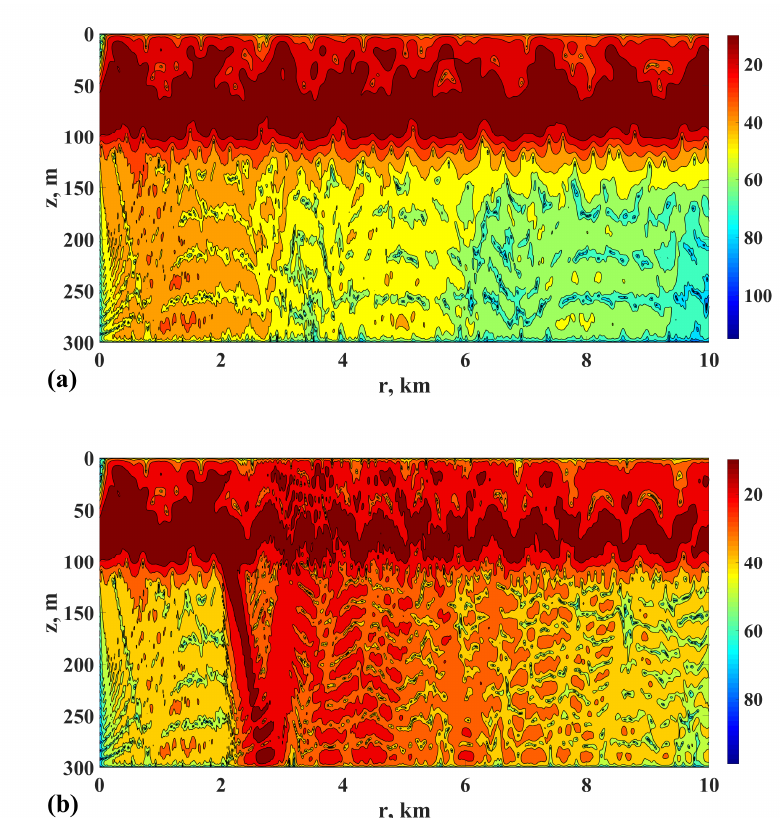
Figure 4. Color plot of the transmission loss (horizontal cylindrical spreading is not taken into account) for the beam emitted with z 0 = 80 m and tan φ = − 0.1. The panel ( a ) corresponds to the waveguide without pockmarks; the panel ( b ) depicts data for the waveguide with pockmark intersecting the waveguide between r 1 = 2000 m and r 2 = 2300